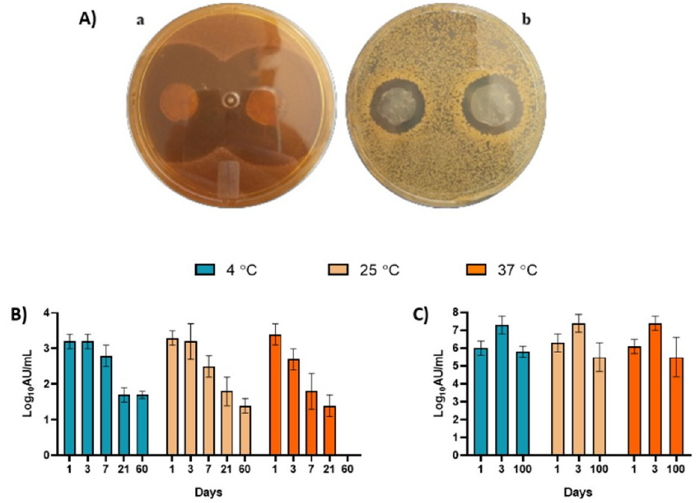
Figure 2. ( A ) Agar diffusion assay of the nisin loaded in BC (N–BC) against L. sakei ( a ) and S. aureus ( b ). ( B ) N–BC stability after storage at 4, 25 and 37 ◦ C evaluated by agar diffusion assay against S. aureus ATCC 10390. ( C ) N–BC stability after storage at 4, 25 and 37 ◦ C evaluated by agar diffusion assay against L. sakei ATCC